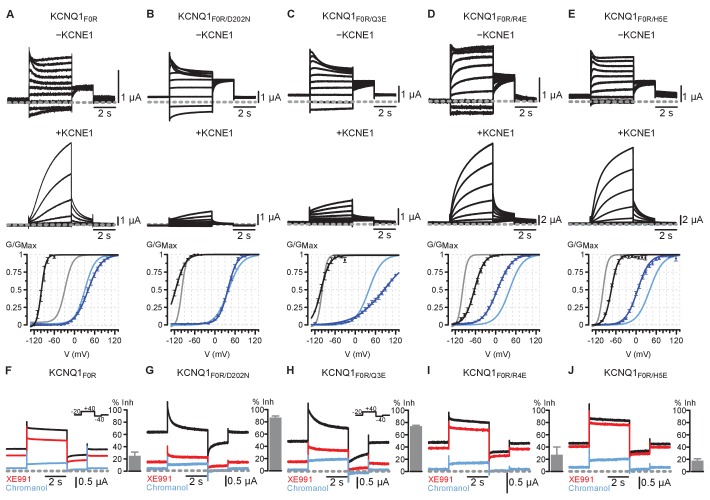
Electrophysiology results for KCNQ1 F0R single and double mutants with and without KCNE1 co-expression, and with XE991 exposure.F0 = F167; Q3 = Q234; R4 = R237; H5 = H240. Residue numbers correspond to human KCNQ1. All error bars are ± SEM. (A) Top: Current recordings of KCNQ1 F0R single mutant with and without KCNE1 co-expression. Bottom: Average GV relationships for KCNQ1 F0R (black, n = 3), KCNQ1 F0R + KCNE1 (dark blue, n = 5), KCNQ1 WT (gray), and KCNQ1 WT + KCNE1 (light blue). The single mutant KCNQ1 F0R exhibited dramatic left-shifted voltage-dependent activation compared to KCNQ1 WT, suggesting that the mutation destabilizes the resting state VSD. KCNE1 co-expression restored voltage-dependent activation to near WT levels and potentiated ionic current compared to the α-subunit alone, suggesting that KCNE1 partly rescues the ability of the single mutant F0R to gate normally. (B–E) Top: Current recordings of KCNQ1 F0R double mutants with and without KCNE1 co-expression. Bottom: Average GV relationships for the KCNQ1 double mutant α-subunit only (black), KCNQ1 double mutant + KCNE1 (dark blue), KCNQ1 F0R (gray), and KCNQ1 F0R + KCNE1 (light blue). All n > 3. (B) F0R/D202N featured a further left-shifted voltage-dependent activation compared to the F0R single mutant. KCNE1 co-expression greatly suppressed F0R/D202N current, suggesting that F0R/D202N favored the intermediate VSD state and IO channel state. (C) F0R/Q3E demonstrated current suppression upon KCNE1 co-expression when compared to α-subunit alone, suggesting that F0R/Q3E favored the intermediate VSD state and the IO channel state. Furthermore, the conductance-voltage (G–V) curve for the mutant KCNQ1 co-expressed with KCNE1 tracks the development of the AO state because KCNE1 suppresses IO-state current. F0R/Q3E+KCNE1 featured a right-shifted voltage-dependent activation compared to F0R single mutant, consistent with the mutant favoring the intermediate VSD state and resisting transition into the AO state. (D–E) F0R/R4E and F0R/H5E double mutants exhibited an opposite phenotype compared to F0R/Q3E. Upon KCNE1 co-expression, ionic currents for F0R/R4E and F0R/H5E were potentiated, and voltage-dependent activation was left-shifted compared to the F0R single mutant. Together, these results suggest F0R/R4E and F0R/H5E favored the activated VSD state and the AO state. Overall, the F0R/Q3E and F0R/D202N double mutants demonstrated phenotypes consistent with the mutants favoring the IO channel state; while F0R/R4E and F0R/H5E exhibited distinct and opposite phenotypes, suggesting that the latter mutants promote the AO channel state. However, the presence of voltage-dependence in these mutants represents a confounding factor, as the VSD retain voltage sensitivity. By adding the S3 D202N mutation into the F0R/Q3E and F0R/H5E mutants, this voltage-dependence was abolished (Main Figure 5), suggesting that the triple mutants highly stabilize the VSD states and that the charge transfer residue S3 D202 plays a role in maintaining the voltage-dependence of the mutants F0R/Q3E and F0R/H5E. Importantly, F0R/Q3E/D202N and F0R/H5E/D202N demonstrated qualitatively identical phenotypes compared to F0R/Q3E and F0R/H5E (Main Figure 5), but without the confounding factor of voltage-dependence. (F–J) Steady-state current recordings of KCNQ1 mutants in control ND96 solution (black), 5 μM XE991 solution (red), and 150 μM chromanol 293B solution (blue). Note that the holding potential was −20 mV as shown by the inset voltage protocols. The −20 mV holding potential yielded non-zero currents before the test pulse because the mutants were constitutively opened. Bar plots show average chromanol-sensitive current inhibition (see Materials and methods). All n > 3. Mutants F0R/D202N and F0R/Q3E demonstrated robust and characteristic IO-current inhibition by 5 μM XE991, consistent with the idea that F0R/D202N and F0R/Q3E favor the IO state. In contrast, mutants F0R, F0R/R4E, and F0R/H5E featured the characteristic AO-current insensitivity to 5 μM XE991, consistent with the hypothesis that these mutations promote the AO state. Critically, XE991 data provided consistent categorization of the F0R single and double mutants when compared to KCNE1 co-expression data (panels A-E), lending further support to the conclusion that these mutants can be classified as promoting the IO state (F0R/D202N, F0R/Q3E) or the AO state (F0R/R4E, F0R/H5E).Figure 5—figure supplement 1—source code 1.MATLAB script that takes in tail current data obtained from PatchMaster program (see Key Resources Table), fits the data with a Boltzmann equation, and outputs the best fit parameters.Figure 5—figure supplement 1—source data 1.Excel file with numerical data used for Figure 5—figure supplement 1.